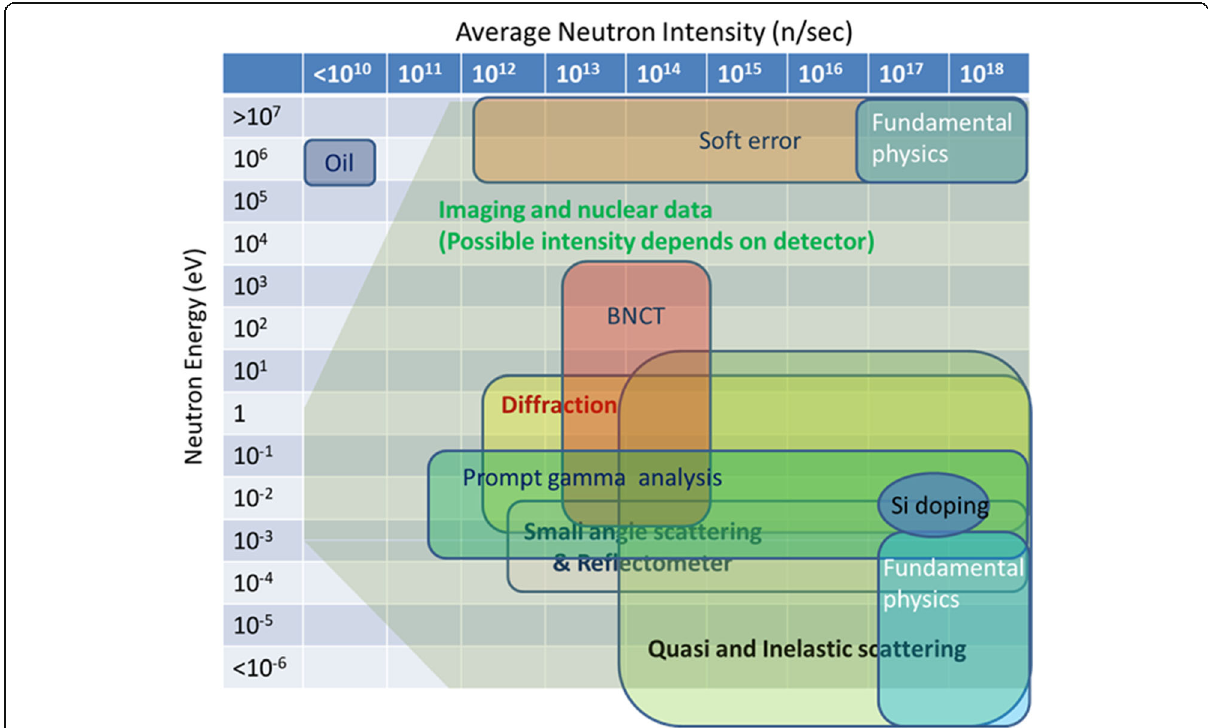
Fig. 1 Neutron intensity and energy range for various neutron applications and